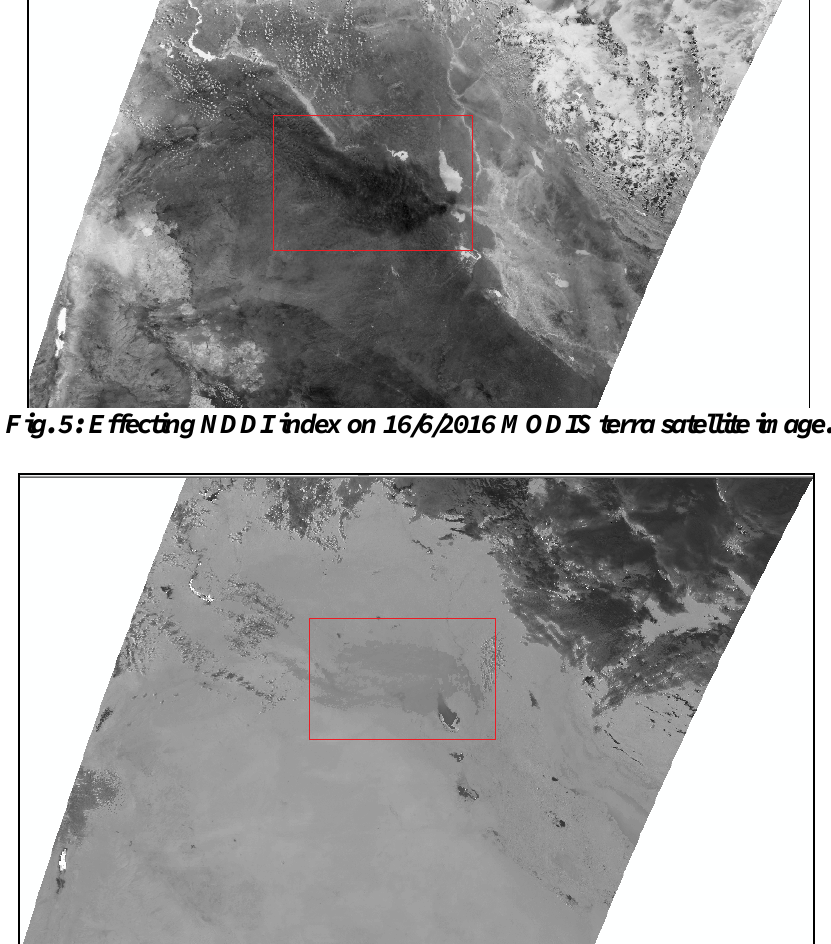
Fig.6: Applying NDDI index on 20/2/2016 MODIS terra satellite